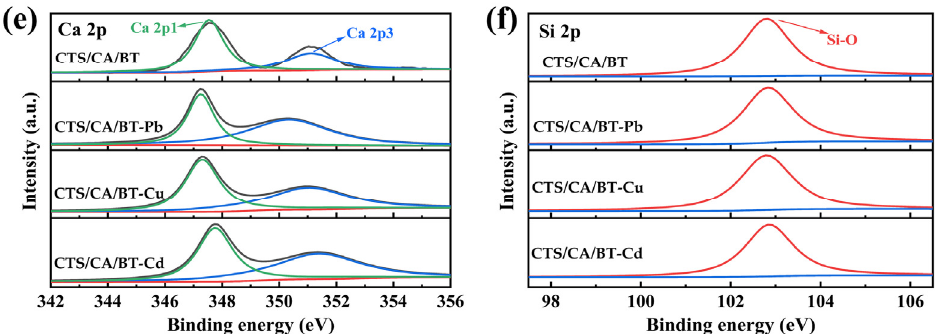
Figure 11. The XPS spectra of CTS/CA/BT composite hydrogel before and after adsorption: ( a ) wide-scan spectra; ( b ) C 1s spectra; ( c ) O 1s spectra; ( d ) N 1s spectra; ( e ) Ca 2p spectra; ( f ) Si 2p spectra.